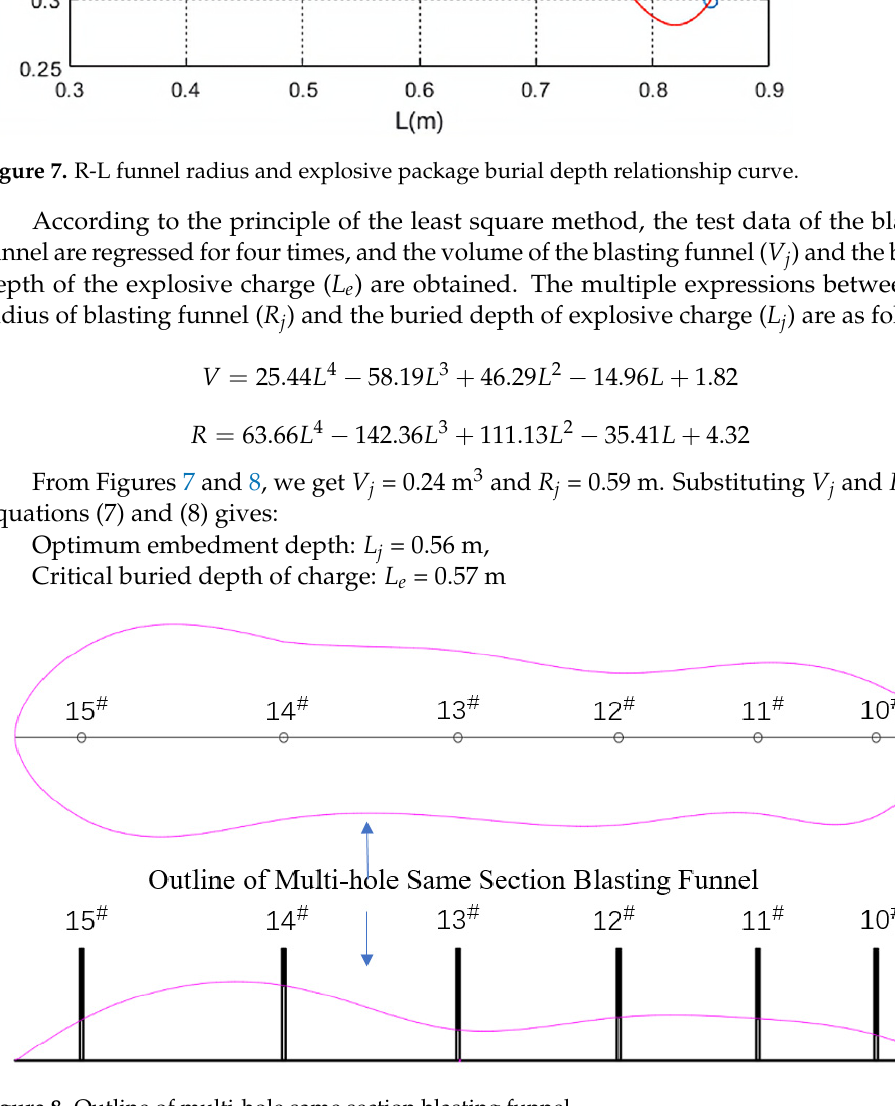
Figure 8. Outline of multi-hole same section blasting funnel.